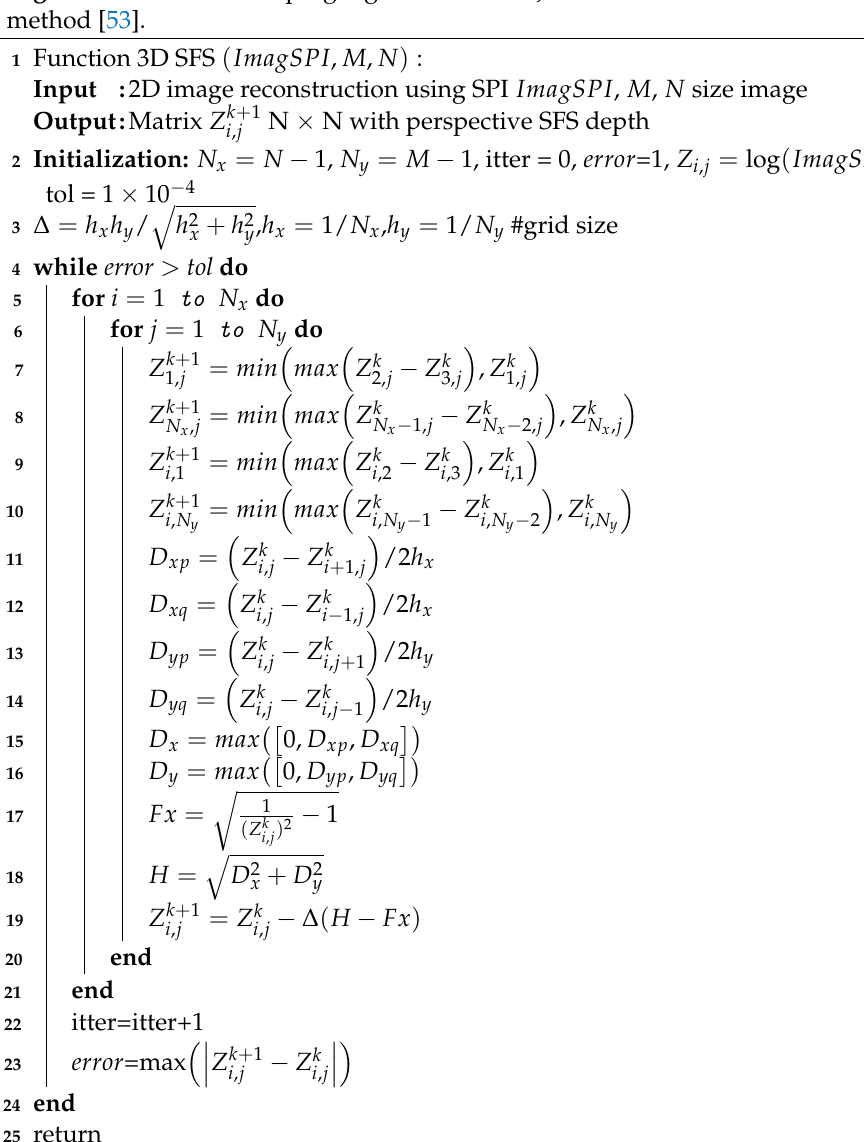
Algorithm A2: Fast sweeping algorithm for H – J based on the Lax–Friedrichs method